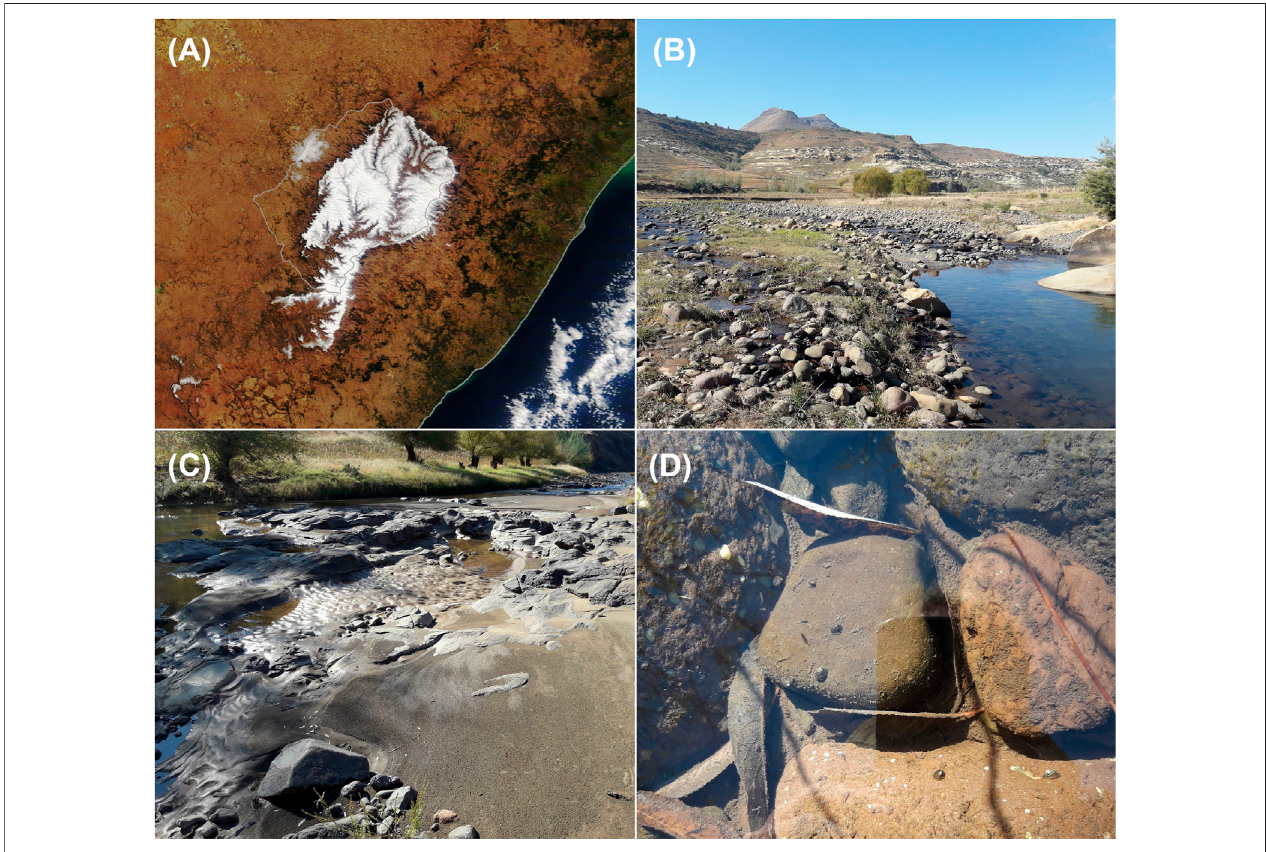
FIGURE 1 | (A) Lesotho Highlands covered in winter snow from space (NASA Earth Observatory images by Lauren Dauphin, using MODIS data from LANCE/ EOSDIS Rapid Response), (B,C) Typical freshwater streams in the Lesotho Highlands and (D) Burnupia attached to rocks in a Lesotho Highland stream.